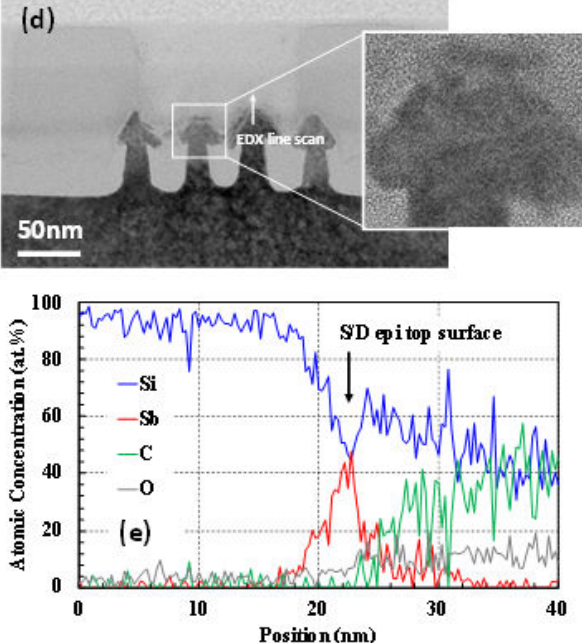
Figure 9. ( a ) Process flow of the FinFET contact modules; ( b ) Structure used for the 3D TCAD simulation; ( c ) Simulated time vs. melting Si fin depth profile during ns UV-LA; ( d ) Cross-sectional TEM image of the Si-based contact module after ns UV-LA; ( e ) Energy-dispersive X-ray spectroscopy line scan taken along the annealed Si fin (the carbon signal comes from the structures surrounding the contact hole). Reprinted/adapted under CC BY 4.0 from Ref. [52]. 2020, T. Tabata et al.